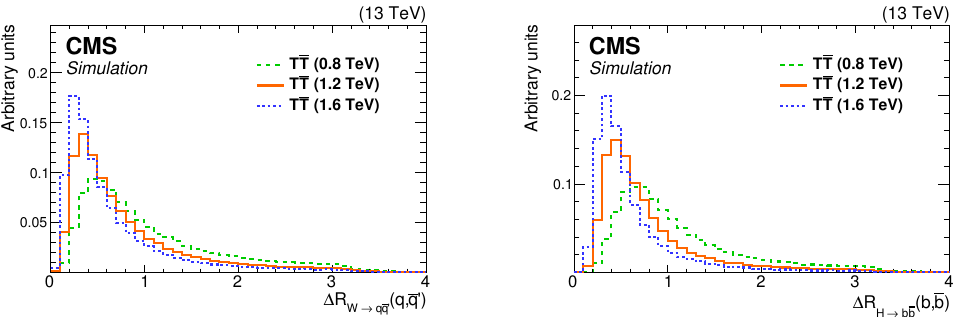
Figure 2 . Angular separations (cid:1) R between the products of simulated W ! qq 0 (left) and H ! bb (right) decay processes for three di(cid:11)erent mass points of the T quark. Even for the lowest mass point shown, the (cid:12)nal state particles are typically emitted with a separation of (cid:1) R < 0 : 8 and are merged into an AK8